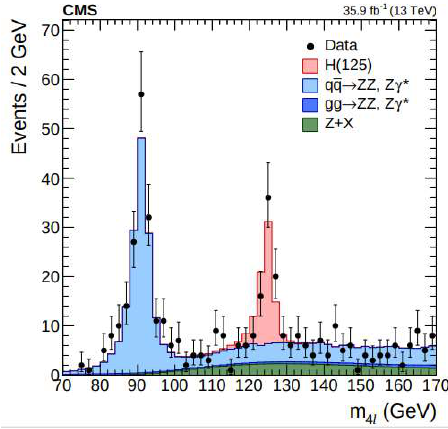
Figure 3. Four-lepton invariant mass from CMS showing, in addition to the Z-boson at 91 GeV, a clear indication of the Higgs boson at 125